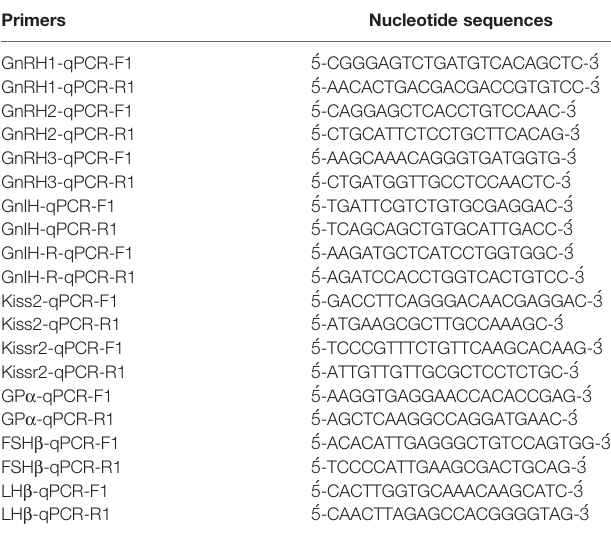
TABLE 2 | Primers used in the real-time PCR assays in this study. Primers Nucleotide